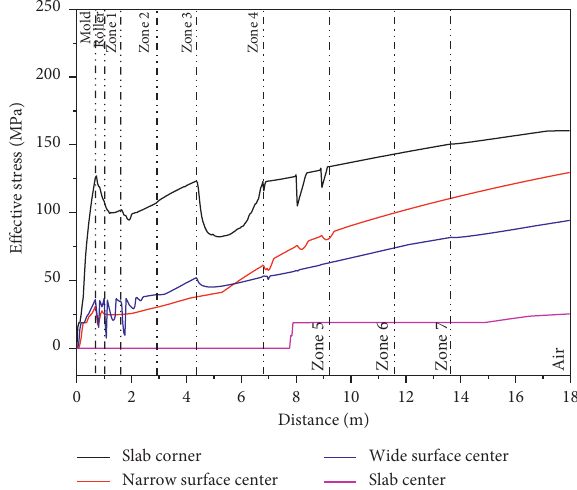
Figure 9: Distribution of effective stress curves at the characteristic